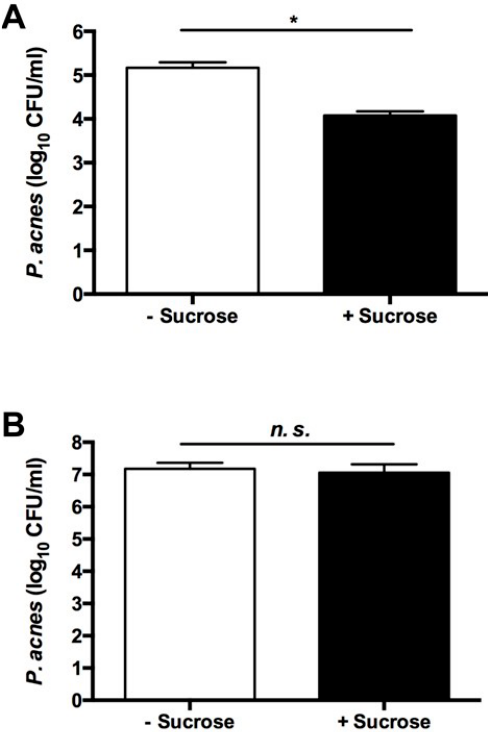
Figure 2. The essential role of sucrose fermentation of S. epidermidis in the inhibition of the growth of P. acnes . ( A ) Fermenting S. epidermidis (ATCC 12228) or ( B ) non-fermenting S. epidermidis (10 6 CFU) were co-incubated with P. acnes (10 6 CFU) in 10 mL rich media with or without 20 g/L sucrose for three days. After incubation, culture media containing bacteria were diluted 1:10–1:10 5 with phosphate buffered saline (PBS) and then spotted the dilution (5 µ L) onto P. acnes selective agar plates which contain rich media and 10 µ g/mL of furazolidone. The number of P. acnes six days after incubation is expressed as log 10 CFU/mL. Data are the mean ± standard deviation (SD) of three separate experiments. * p < 0.05 (two-tailed t -tests). n.s . = not significant.